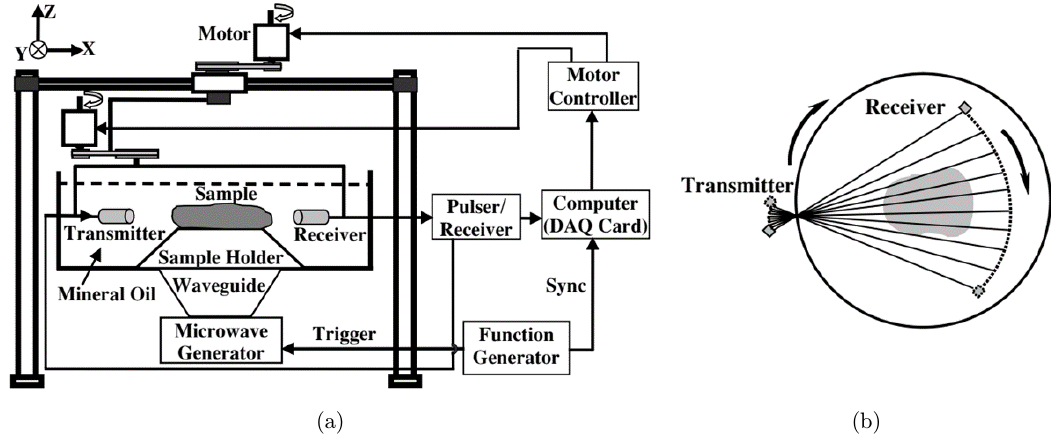
Fig. 9. Experimental set-up (a) and scanning geometry (b) of the combined USCT and thermoacoustic tomography system. Reproduced with permission from Ref.